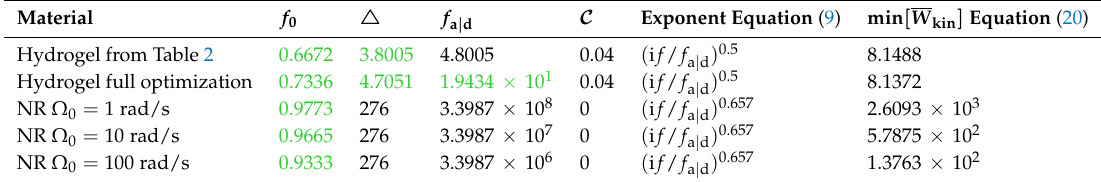
Table 3. Optimized hydrogel and natural rubber dynamic vibration damping properties in green at various natural frequencies for the primary vibration system Ω 0 with α = 0, χ = 1/10, f − = 0.5 and f + =